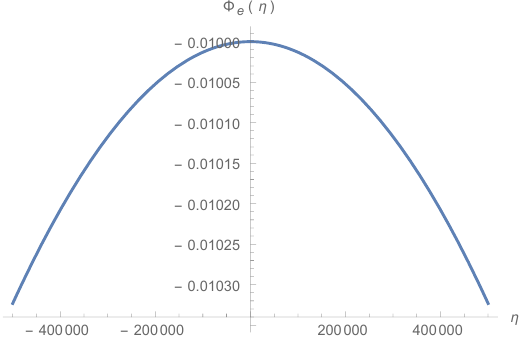
Figure 10. Time evolution of Φ e in the Jordan frame for the initial conditions Φ e ( 0 ) = − 10 − 2 , − 3 , Φ (cid:48) Ψ ( 0 ) = 0, Ψ (cid:48) ( 0 ) = 0. The background evolution is the one obtained by assuming the e ( 0 ) = 10 e e same initial conditions as mentioned in the caption of Figure